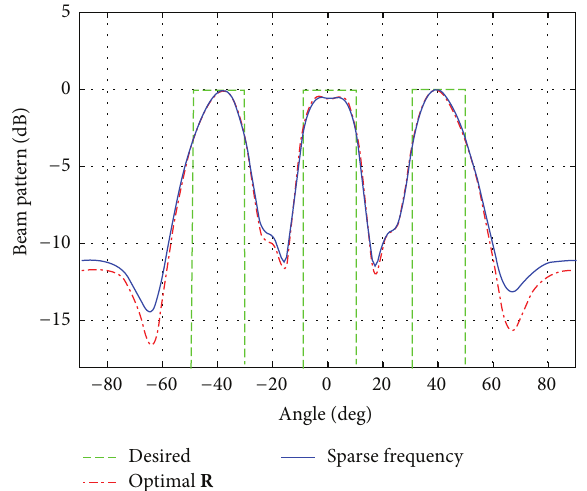
Figure 8: Beam pattern of sparse frequency waveforms and desired beam pattern and beam pattern of optimal covariance matrix R (multibeam